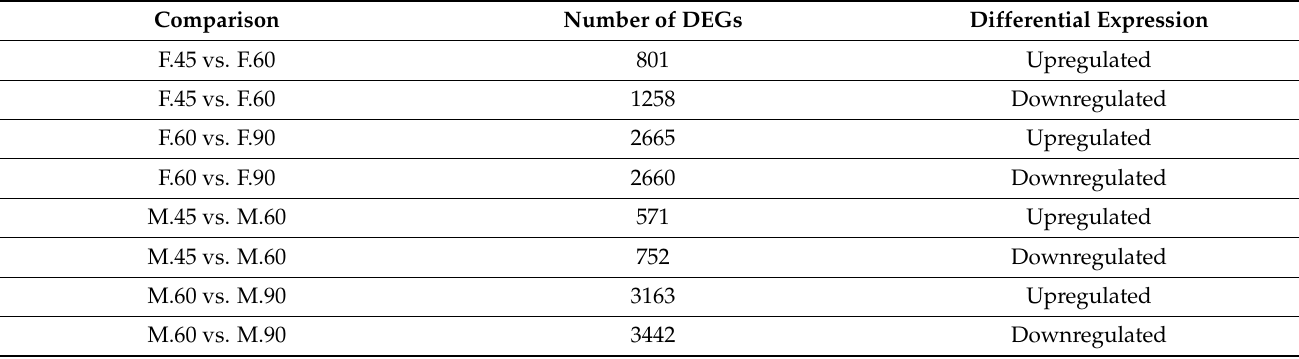
Table 1. Number of DEGs in developing male (M) and female (F) porcine fetal brains between GDs 45 vs. 60 and GDs 60 vs. 90. The direction of differential expression is also